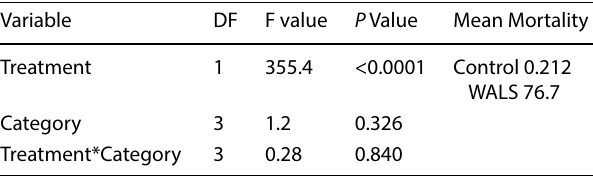
Table 2 ANOVA table for larval bioassay data. Treatment: Control and WALS, Category: exposed, dense, sparse or